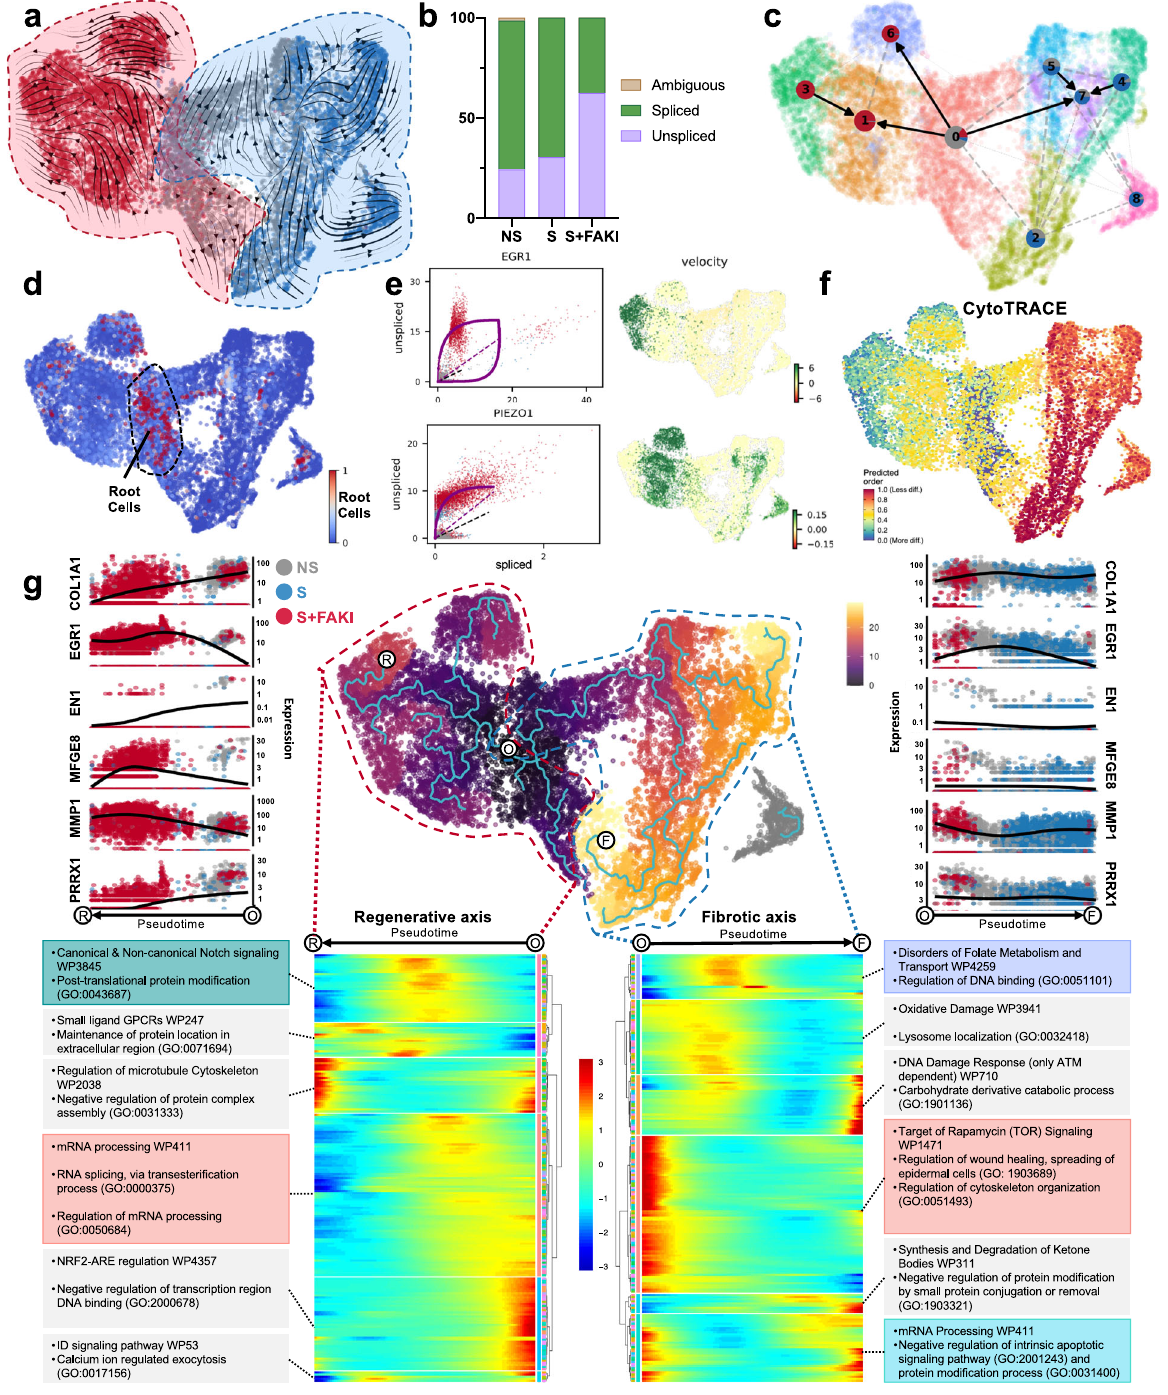
Fig. 5 Mechanotransduction regulates opposing trajectories of pro fi brotic and regenerative fi broblast differentiation fates. a RNA velocities shown as the main gene-averaged fl ow, visualized by velocity streamlines projected onto the UMAP embedding. b Ratio of spliced to unspliced mRNA residuals in the three groups. c Partition-based graph abstraction (PAGA) showing the connectivity of cellular clusters with edge weights representing con fi dence in the presence of connections. d Root cells of cellular differentiation as identi fi ed by RNA velocity analysis. e Left: Gene-resolved velocities for EGR1 and PIEZO1 . The dotted line represents the estimated ‘ steady-state ’ ratio of unspliced to spliced mRNA abundance. RNA velocities are the residuals from the steady-state line, with positive velocities indicating an upregulation of a gene (i.e., a higher abundance of unspliced mRNA than expected in the steady state). Right: Gene-speci fi c RNA velocity projected onto the UMAP embedding. f Cells colored by CytoTRACE scores. g Cells colored by pseudotime determined using the Monocle3 package. White dots delineate the root of trajectory origin (O), end point for the regenerative axis (R), and end point for the fi brotic axis (F). Expression of key marker genes is plotted over pseudotime along both regenerative (left) and fi brotic (right) trajectories. Bottom panel shows pseudotime heatmaps for regenerative (left) and fi brotic (right) trajectories and corresponding enriched genesets per heatmap cluster (Human WikiPathways and GO